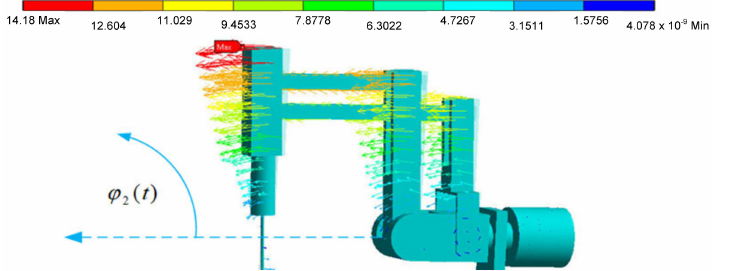
Figure 25. Displacement vector diagram in [mm] for the movement of the surgical robot at the second